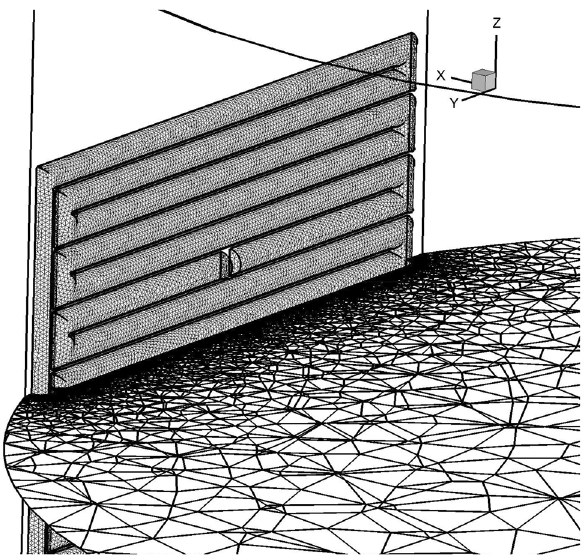
Fig. 5 Planar view of generated grid inside the EAF domain in first step (receiving heat flux)